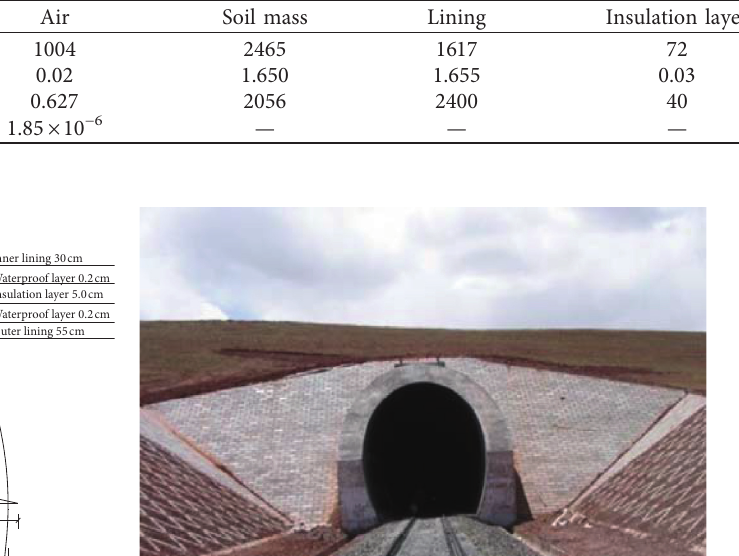
Table 4: Physical parameters of air, soil mass, lining, and insulation layer.